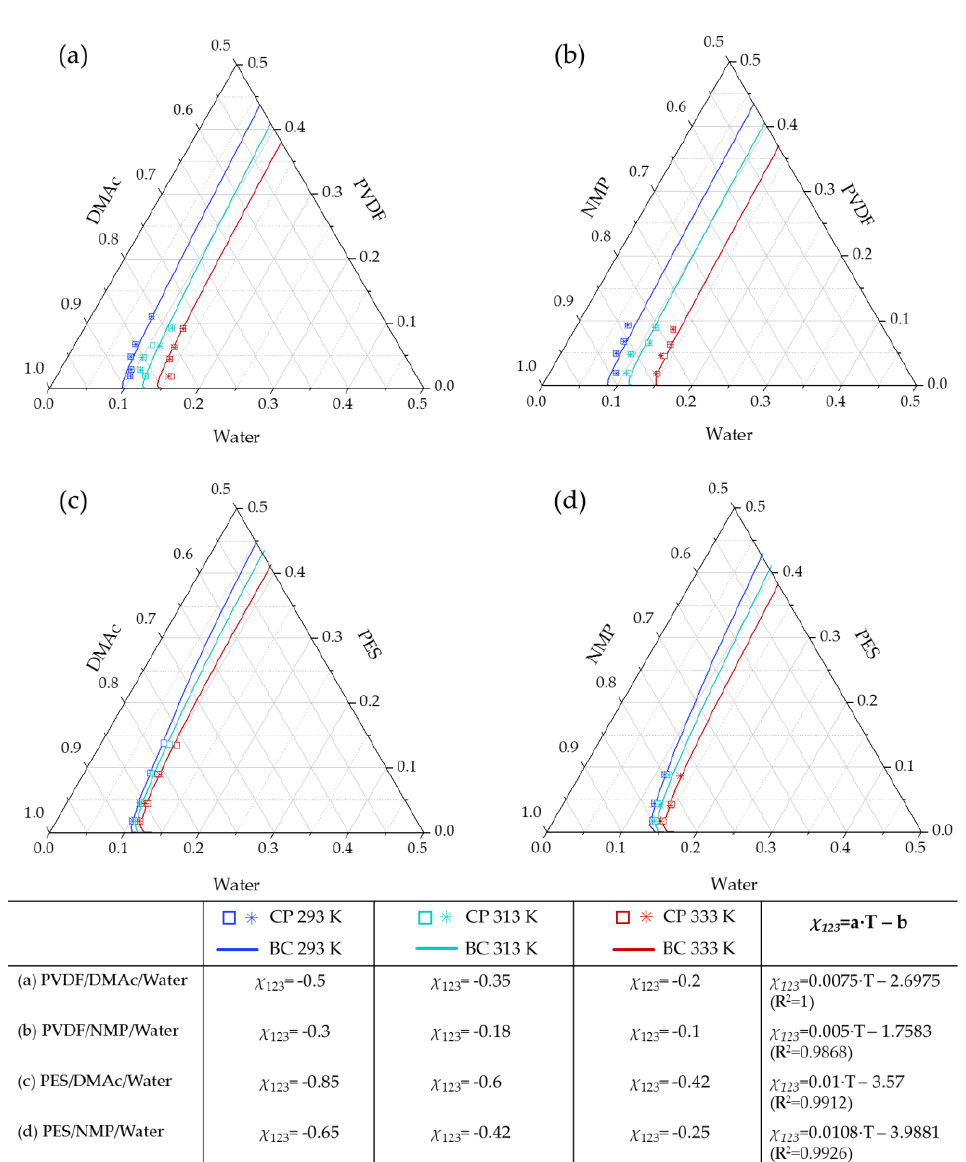
Figure 7. Binodal curves using adjusted χ 123 interaction parameter ( a ) PVDF – DMAc – water, ( b ) PVDF – NMP – water, ( c ) PES – DMAc – water and ( d ) PES – NMP – water systems. Duplicated experimental results are represented by (cid:3) and